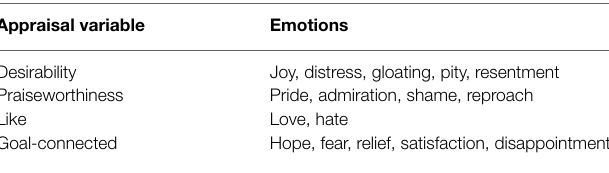
TABLE 1 | Referencing the emotions to the appraisal variables, based on OCC (Dias et al., 2014)